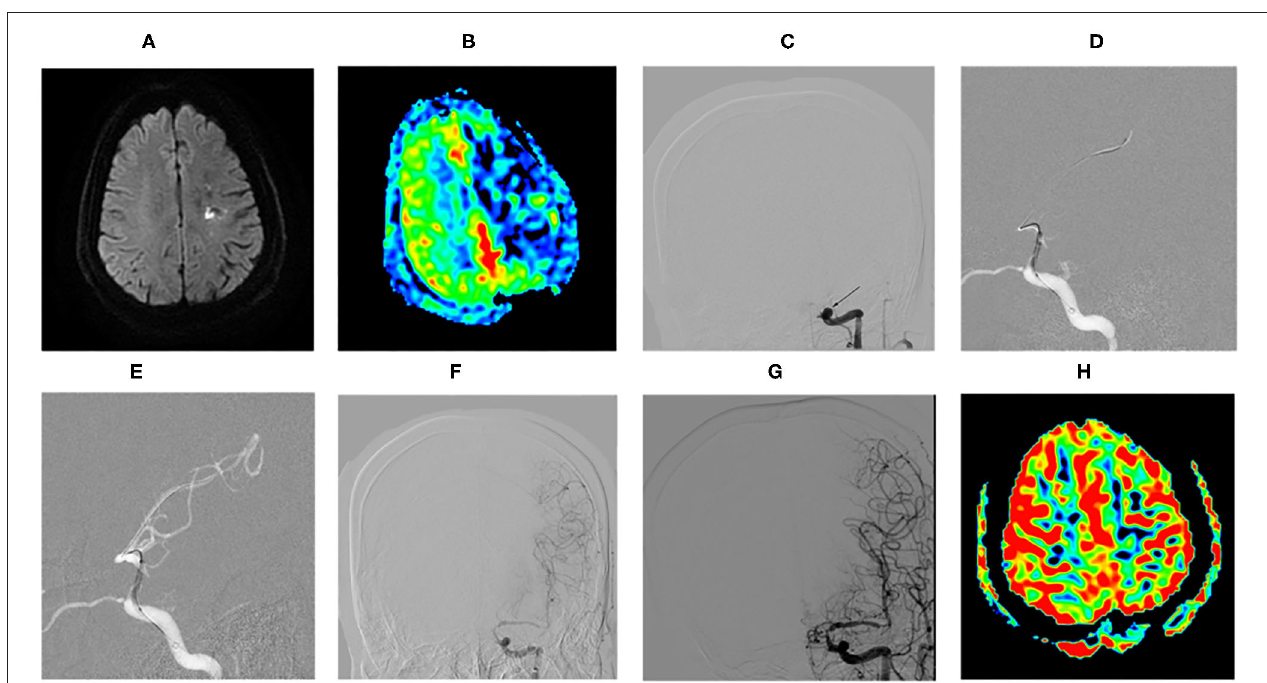
FIGURE 2 | Example of comparing the preoperative MRI and operative angiographic findings with follow-up. (A) MRI revealed left watershed infarction. (B) ASL showed left cerebral hemispheric hypoperfusion in the ICAO territory. (C) DSA confirmed the left internal carotid artery terminus occlusion ipilaterally to the infarcts (arrow). (D) Predilatation with a conventional balloon. (E) DCB dilatation after predilatation. (F) DSA showed the occlusion recanalization with 70% residual stenosis with a large number of thrombus (arrow). (G) DSA showed thrombus disappeared and residual stenosis rate improved with 50% residual stenosis at angiographic follow-up of 1 month (arrow). (H) ASL showed basically symmetric bilateral cerebral hemispheric perfusion at angiographic follow-up of 1 month.